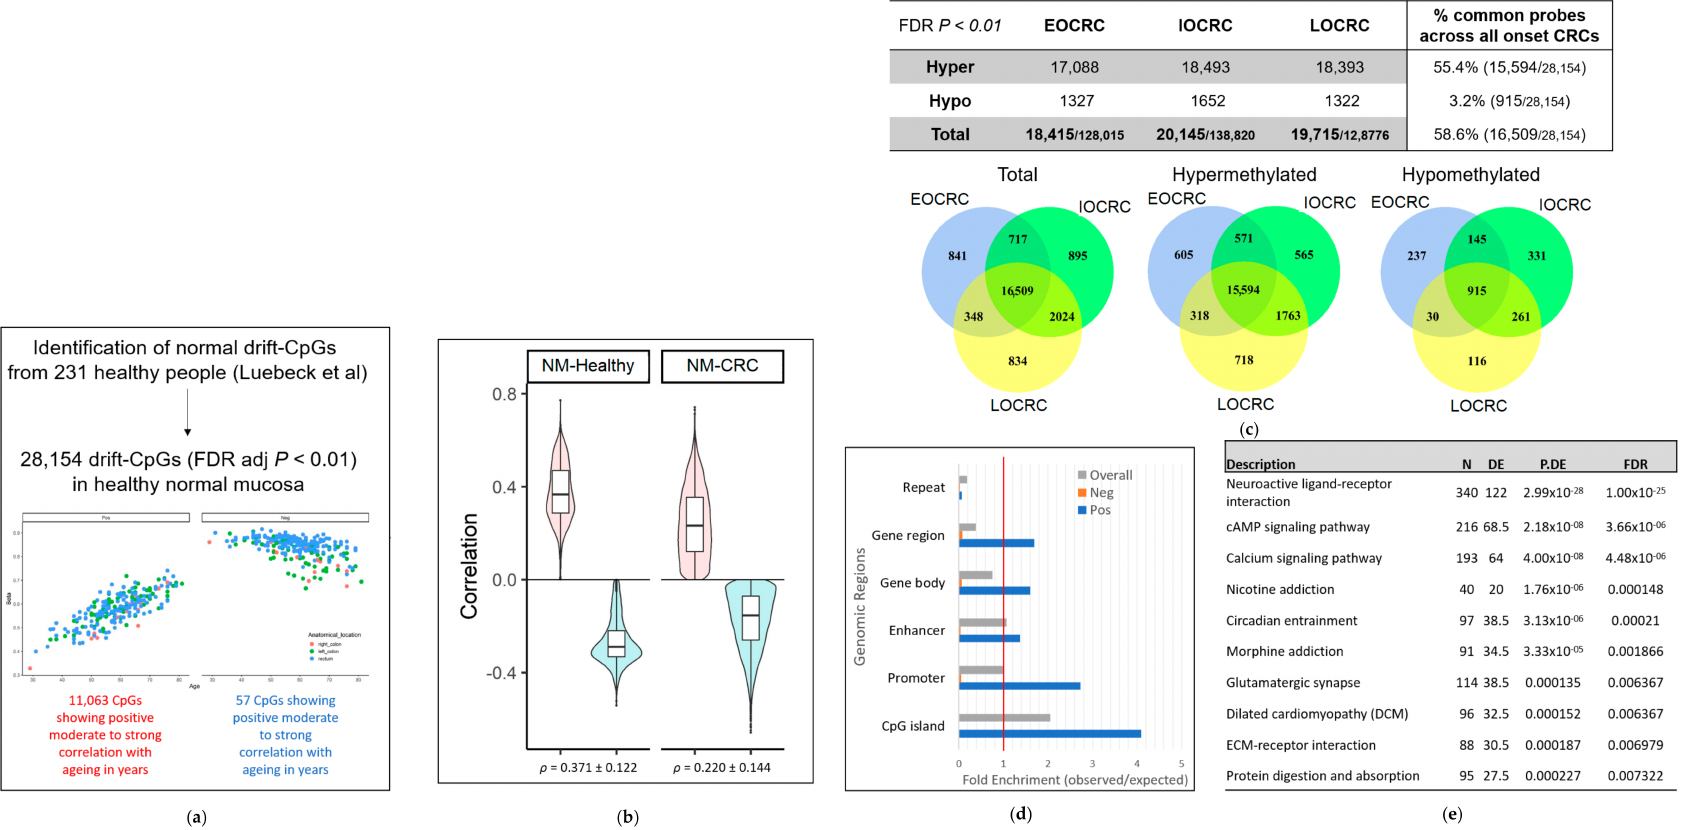
Figure 2. CpGs associated with the methylomic drift in normal colonic mucosa and those that are also DMPs in CRCs ( a ) 28,154 CpGs were identified where methylation levels were either positively or negatively correlated with increasing age, i.e., “drifts-CpGs”. ( b ) Spearman’s correlation coefficients for 26,886 positively correlated probes (red) and 1268 negatively correlated probes (blue) in normal mucosa from healthy control (“NM-healthy”, left) and people with CRC from this study (“NM-CRC”, right). ( c ) A table and Venn diagrams showing the breakdown of hypermethylated and hypomethylated cancer-associated drift-CpGs each for EOCRC, IOCRC, and LOCRC. ( d ) The representation of genomic regions (CpG island, gene promoter, enhancer, gene body, and repeat) for 16,509 cancer-associated drift CpGs common between all three age groups that were either positively or negatively correlated drift-CpGs. ( e ) Top 10 KEGG pathways associated with 16,509 cancer-associated drift